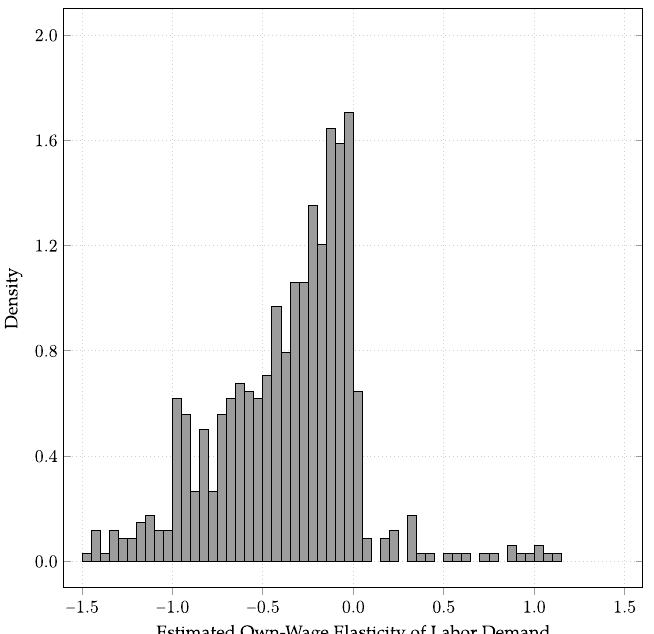
Fig. 1 Distribution of own-wage elasticity of labor demand. The histogram illustrates the distribution of estimated own-wage elasticities of labor demand for Germany. For better illustration, the graph is truncated at